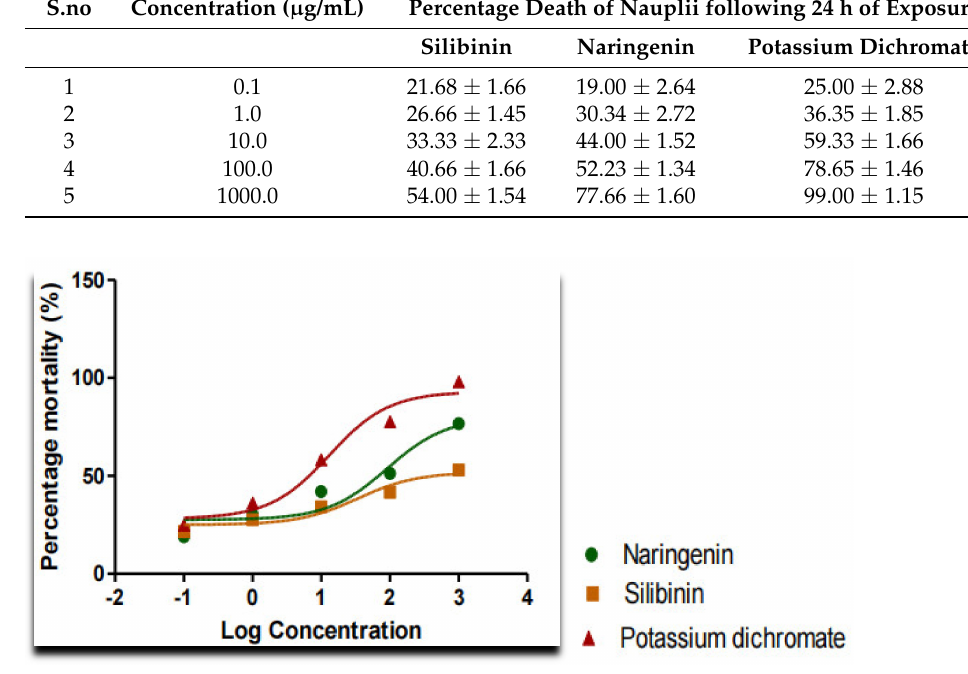
Figure 3. Brine shrimp lethality assay of the treated